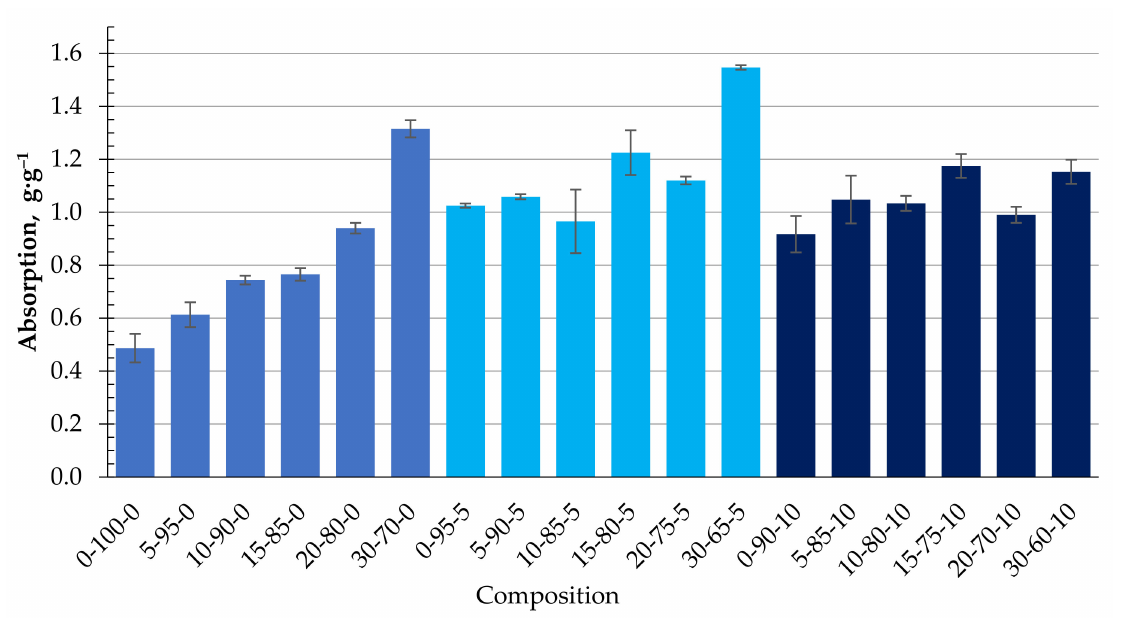
Figure 9. Absorption capacity (g · g − 1 ) of DF depending on the composition of the composite. Their ability to bind motor oil, with a viscosity much higher than DF, was also deter- mined for the different granule compositions obtained. For all formulations, the maximum rate of MO retention was achieved in the first minutes of contact and practically did not increase with increasing residence time (Figure 10). This indicates a different mechanism of retention of MO by the biocomposite granules compared to that of diesel fuel. Figure 11 shows the maximum degree of MO retention achieved for all the granule formulations tested. The introduction of CR particles into the composition contributes to motor oil binding insignificantly. At the same time, the use of CS, additionally, as a filler increases the ability to bind motor oil on average by 38% compared with granules containing only CR and reaches the value of 0.65 ± 0.05 g · g − 1 .